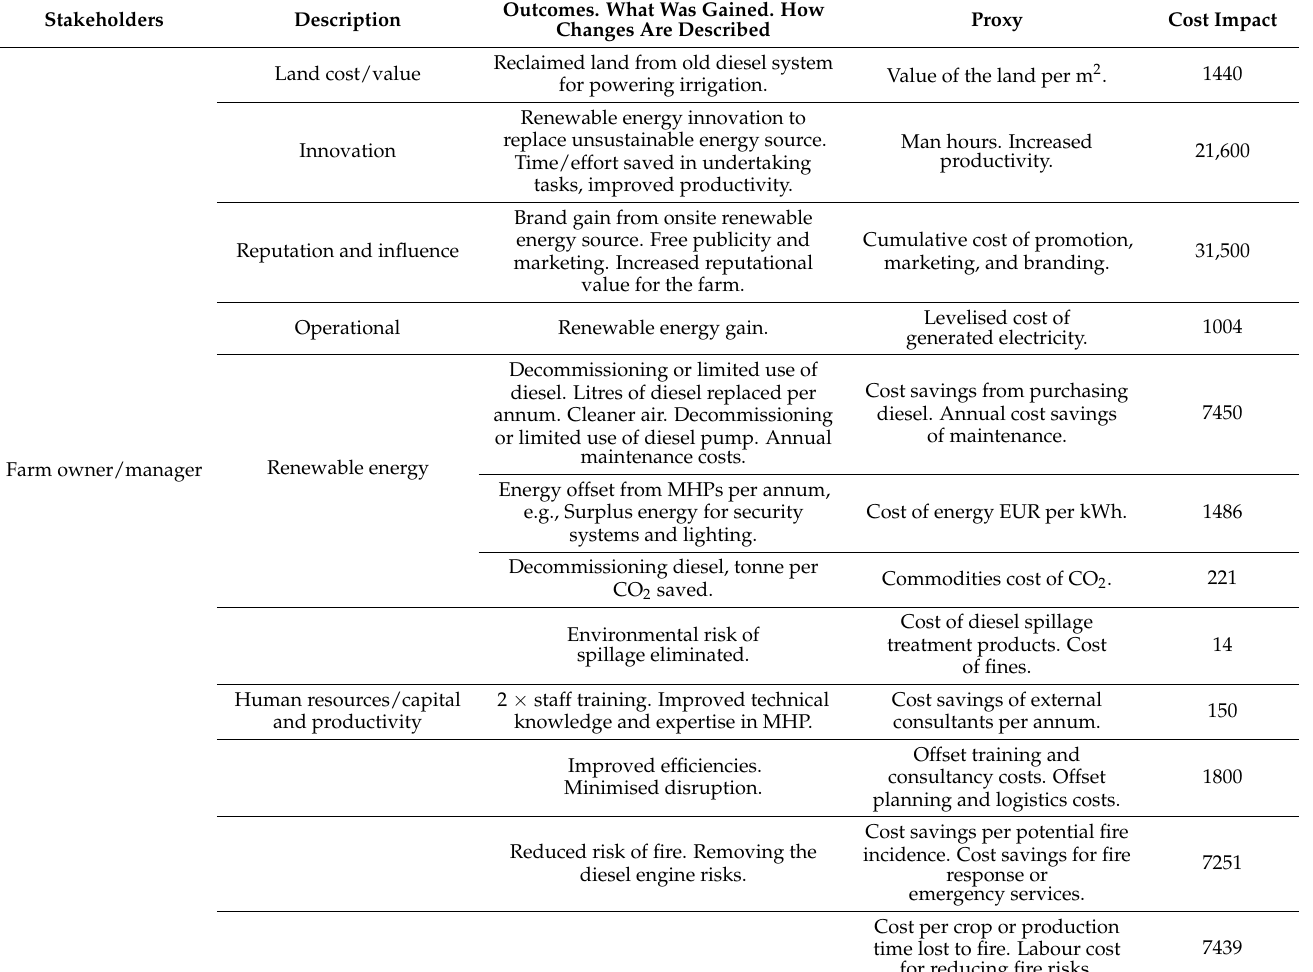
Table 3. Estimating SROI for the Spanish demonstrator. Cost impact estimates, quantity times, financial proxy, less deadweight, displacement, and attribution. All values to nearest